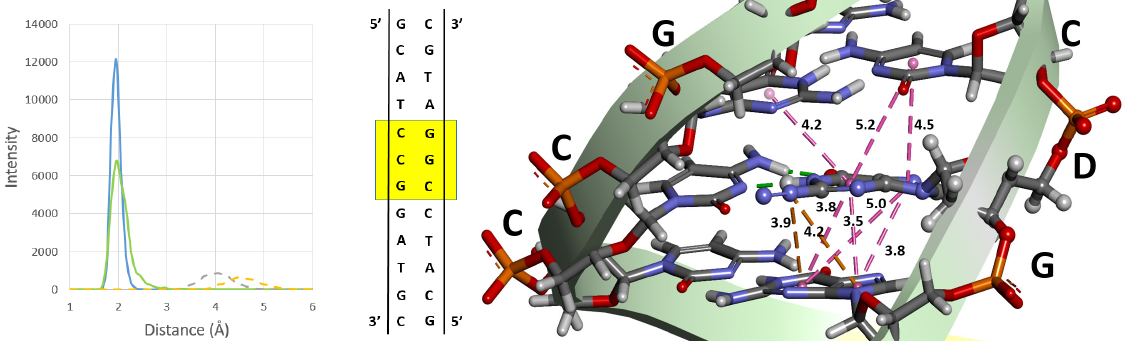
Figure 1. Histograms of distances during the MD simulations (Left Panel) and a representation of principal interaction schemes in the dodecamer DNA models for the DI (Central and Right Panel). The solid blue and green lines represent the histogram of hydrogen bonding for the G–D pairs in the diazonium DNA model and the dashed gray and yellow lines are the major histograms for the cation- π interactions during the MD simulations. A representative figures of the base in the oligonucleotide model (Right Panel) and its place in the dodecamer (yellow square) are also shown. Pink lines are pi–pi stacked interactions; orange lines are cation– π interactions.